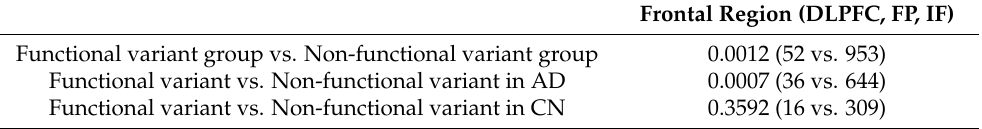
Table 1. Statistical difference between groups with and without SRE-impacting low-frequency